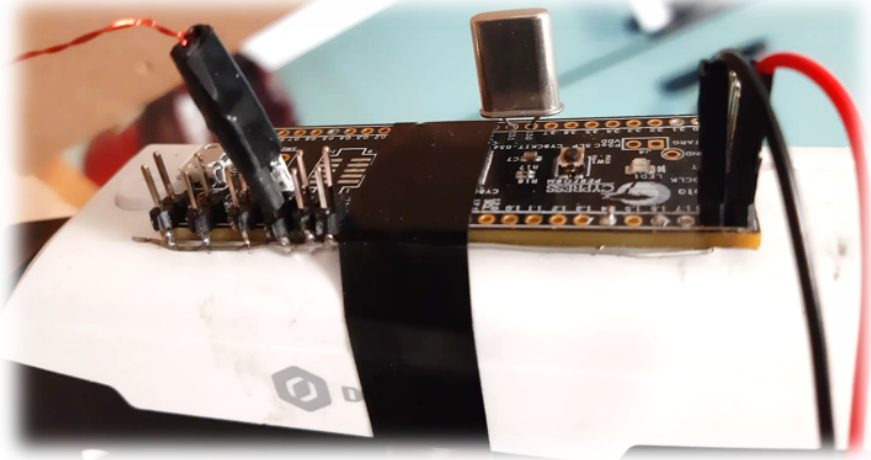
Figure 4. A PSoC5 microcontroller mounted on a robotic arm: connectors for the TXs are shown on the left. Only one TX is connected in this